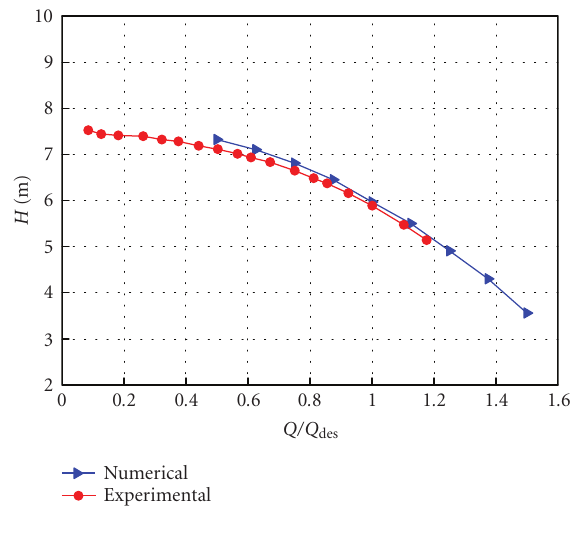
Figure 3: Characteristic